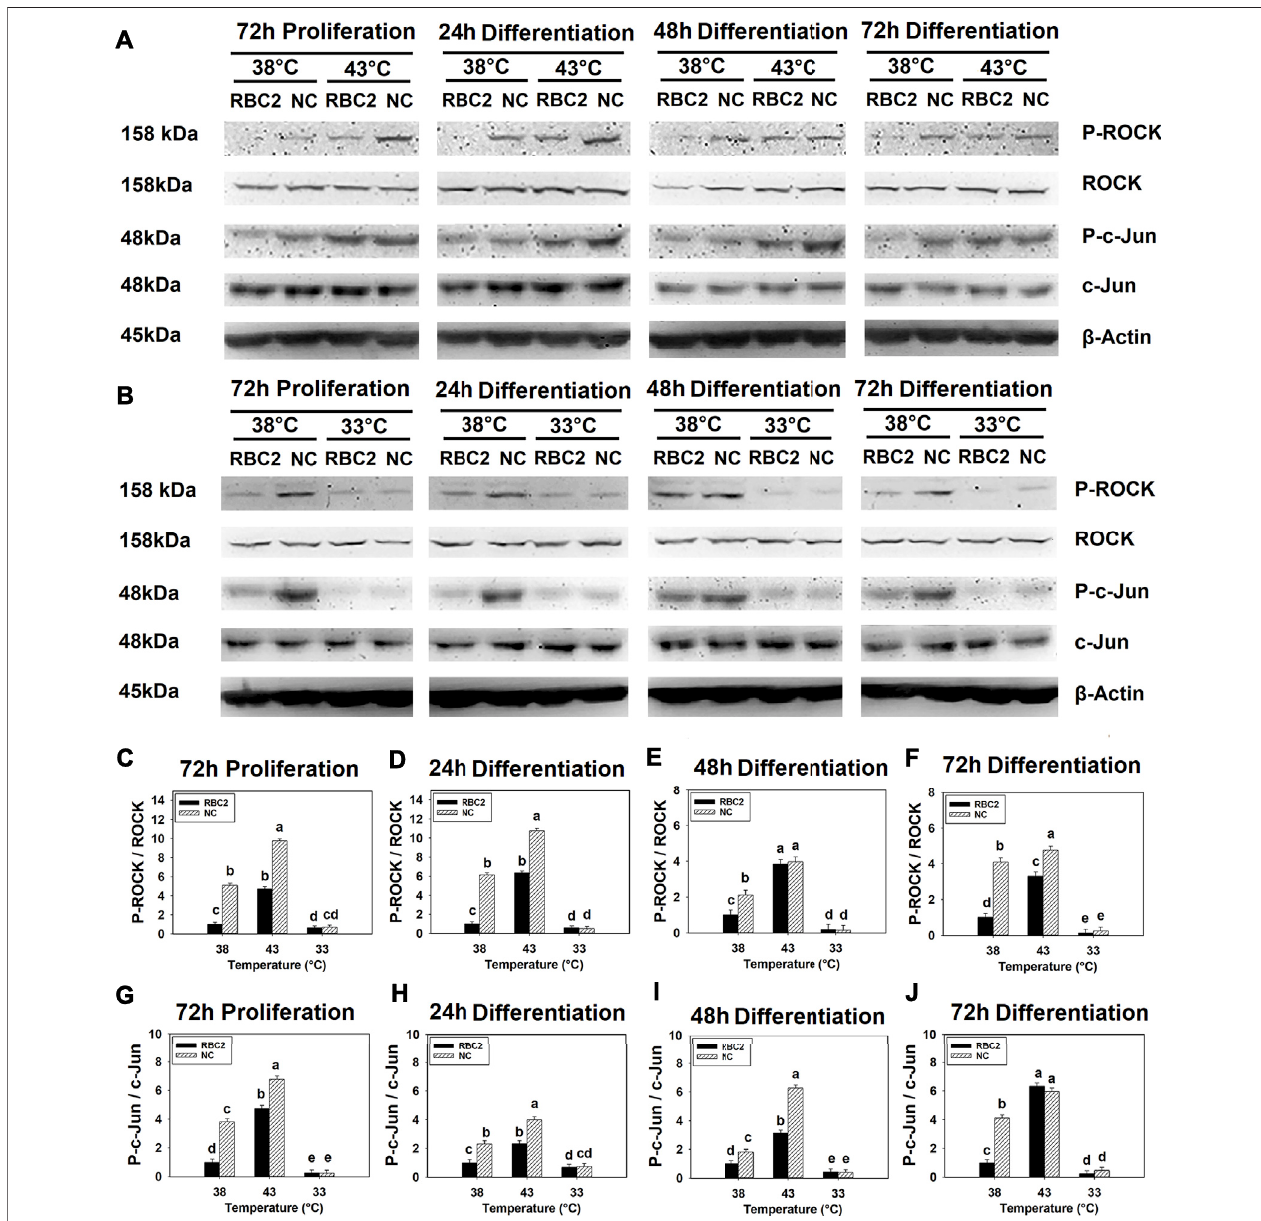
FIGURE 1 | Effect of hot and cold thermal stress on the phosphorylation of rho-associated protein kinase (ROCK) and c-Jun in satellite cells (SCs). (A) Western blotsofunphosphorylatedandphosphorylatedROCKandc-Jun,andaninternalcontrol β -actinintheRandombredControlLine2(RBC2)andmoderncommercial(NC) lineSCsculturedat38 ° Cor43 ° Canddeterminedat72 hofproliferation(alsorepresents0 hofdifferentiation)and24,48,and72 hofdifferentiation. (B) Westernblotsof unphosphorylated and phosphorylated ROCK and c-Jun, and an internal control β -actin in the RBC2 and NC line SCs cultured at 38 ° C or 33 ° C and determined at 72hP, 24hD, 48hD, and 72hD. Molecular weight is on the left and protein name is on the right side of each fi gure, respectively. The ratio of phosphorylated to unphosphorylated ROCK band density was calculated at 72 h of proliferation (C) , 24 h (D) , 48 h (E) , and 72 h (F) of differentiation. The ratio of phosphorylated to unphosphorylatedc-Junbanddensitywascalculatedat72 hofproliferation (G) ,24 h (H) ,48 h (I) ,and72 h (J) ofdifferentiation.Eachgraphbarrepresentsameanratio, and each error bar represents a standard error of the mean. Mean values with different letters are signi fi cantly different ( p ≤ 0.05).